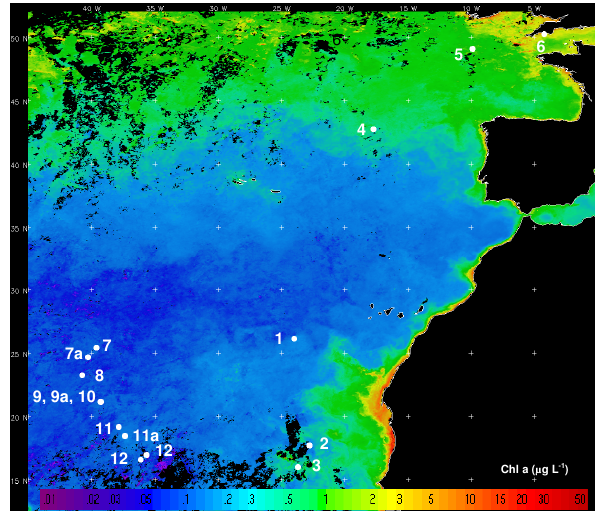
Fig. 1. Sample locations and the composite chlorophyll- a image for October 2009 from the MODIS sensor on the NASA Aqua satellite (courtesy of NERC Earth Observation Data Acquisition and Analysis Service (NEODAAS) at Plymouth Marine Laboratory,